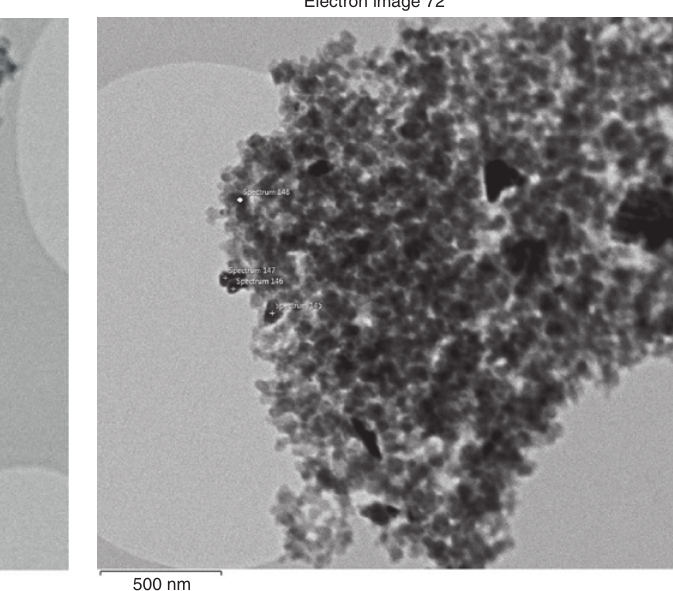
Figure 8: EDS on STEM of carbon-magnetite hybrid filler: spectra positions (136–144).